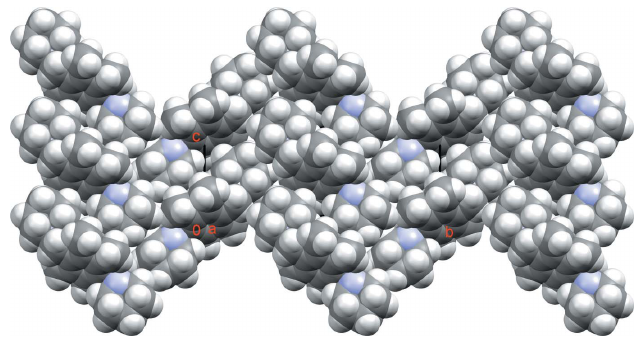
Figure 2 Part of the crystal packing showing the wave-like architecture. View is along the a axis.